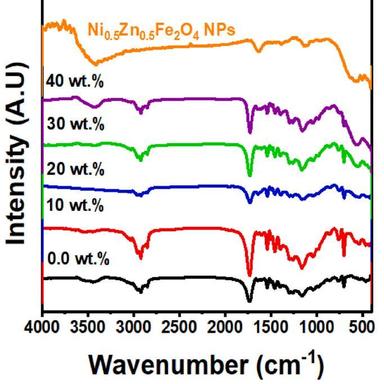
FTIR spectra for both nanoparticles and Polyester doped different concentrations of Ni0.5Zn0.5Fe2O4 nanoparticles (0.0, 10.0, 20.0, 40.0 wt%).